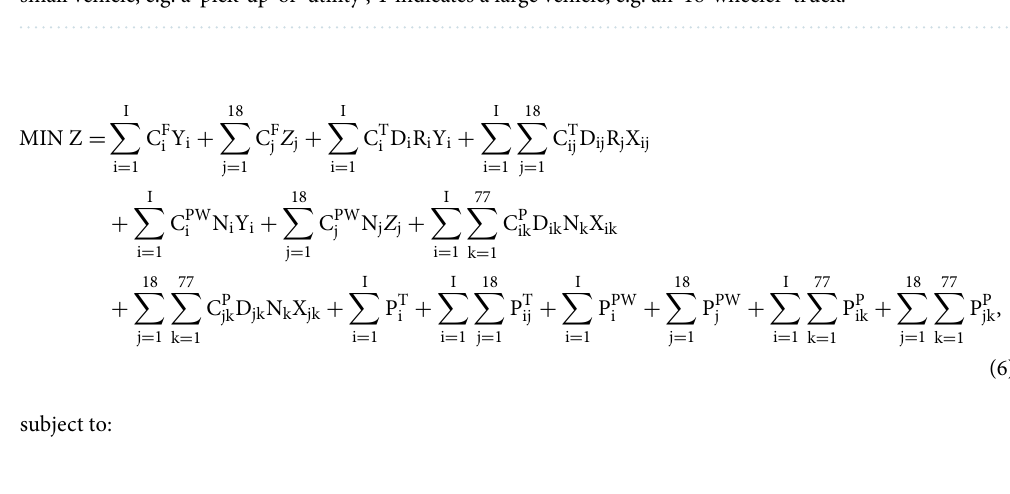
Table 2. Parameters and decision variables including their definitions for location selection. PW indicates a small vehicle, e.g. a ‘pick-up’ or ‘utility’; T indicates a large vehicle, e.g. an ‘18-wheeler’